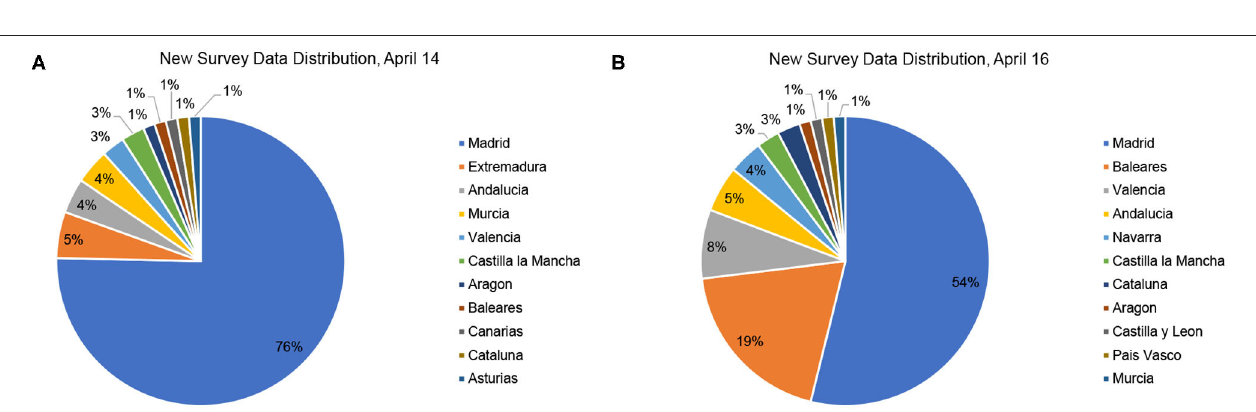
FIGURE 2 | Convergence of correlation with number of responses (A) and day of the month (B) . The line represents the resulting R squared correlation, the dots in the line represent sampling points. The bars represent the number of new daily responses.